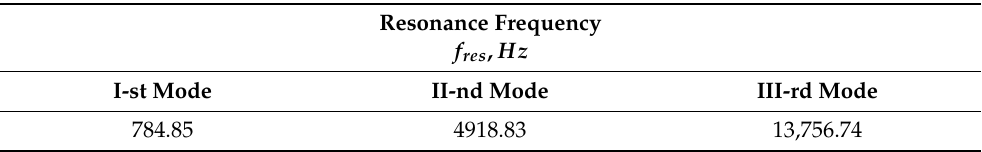
Table 2. Summary of the results of the calculated frequencies of resonant vibrations of the beam with the geometry convergent with the compressor